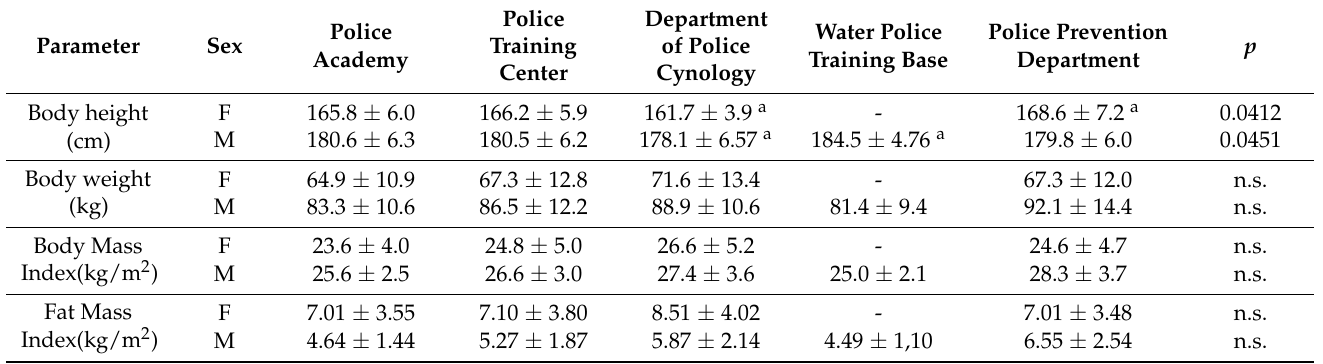
Table 2. Characteristics of police officers with the detailed breakdown by individual